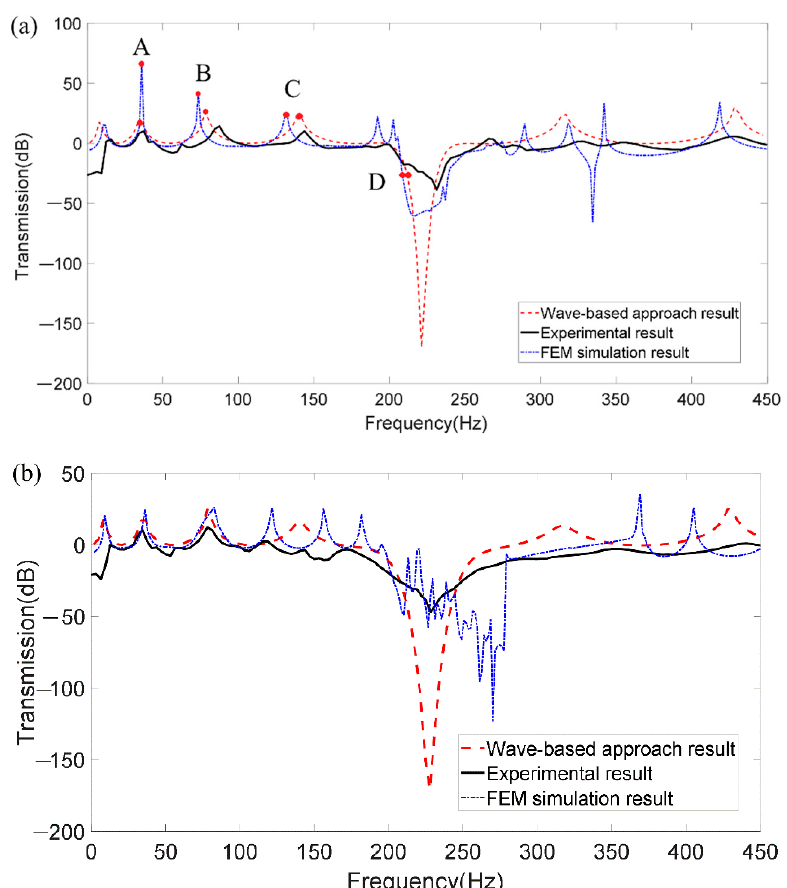
Figure11. Thenumericalandmeasuredfrequencyresponsecurvesof( a )resonator1, and( b Figure 11. The numerical and measured frequency response curves of ( a ) resonator 1, and ( b ) resonator 2.